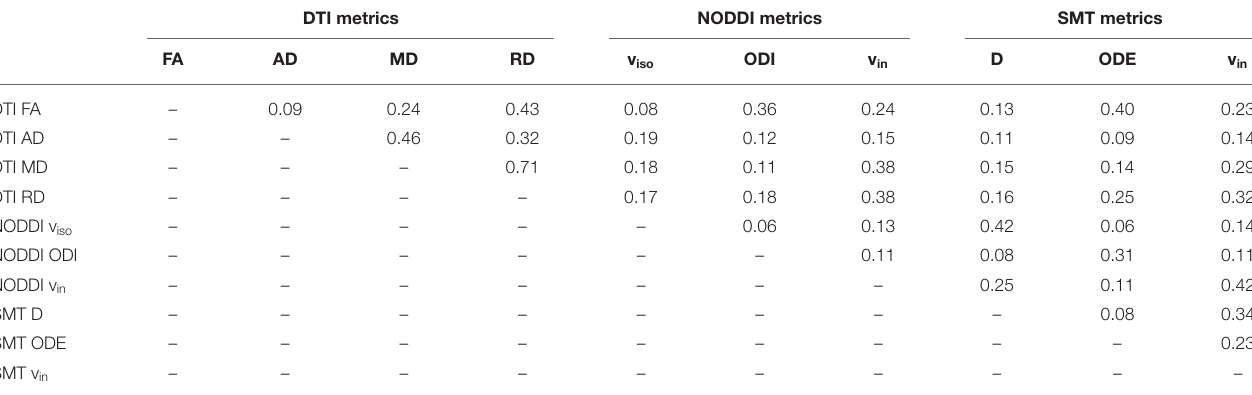
TABLE 4 | Extent of the spatial overlap, measured by the Dice coefficient (0: no overlap; 1: full overlap), among areas exhibiting statistically significant patient-control differences for all MRI metrics (DTI, NODDI, and